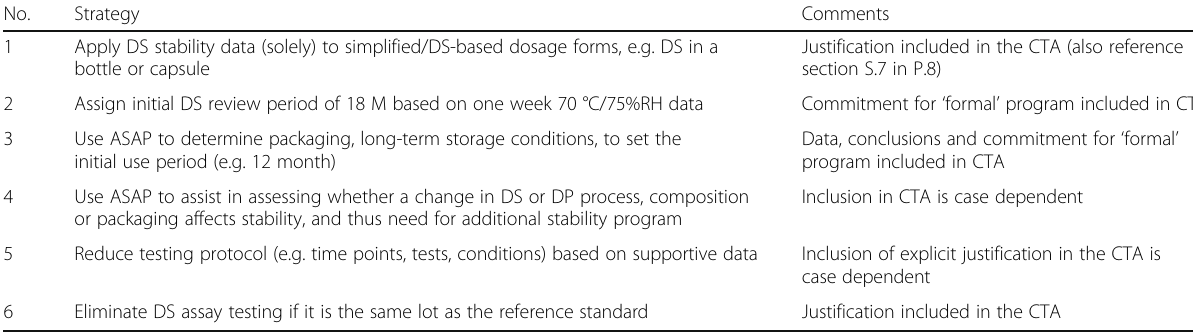
Table 2 Examples of Clinical Lean Stability Strategies